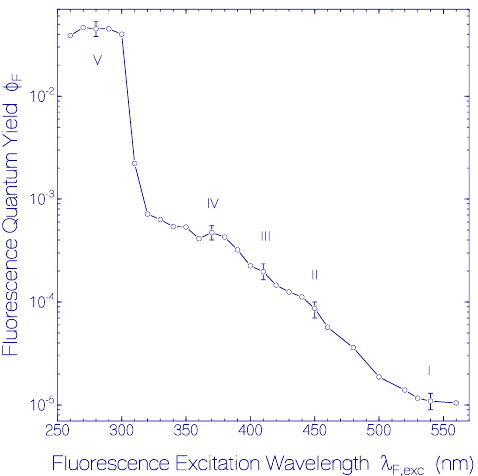
Figure 3. Dependence of fluorescence quantum yield φ F of fresh CaRh in pH 7.3 HEPES/MOPS buffer versus fluorescence excitation wavelength λ F,exc in the region from 560 to 260 nm. Numbers I–V indicate origins from different excitation transitions.